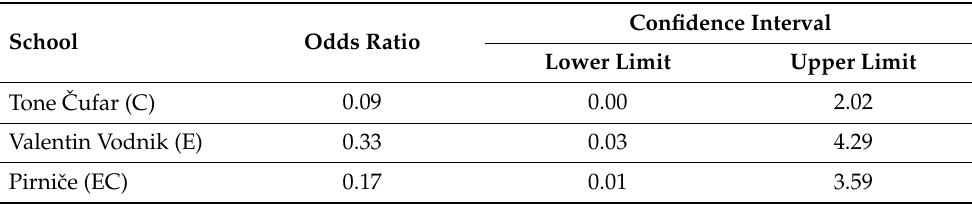
Table 6. Risk of obesity in intervention groups (Communication (C); Environmental (E); and double intervention Communication and Environmental